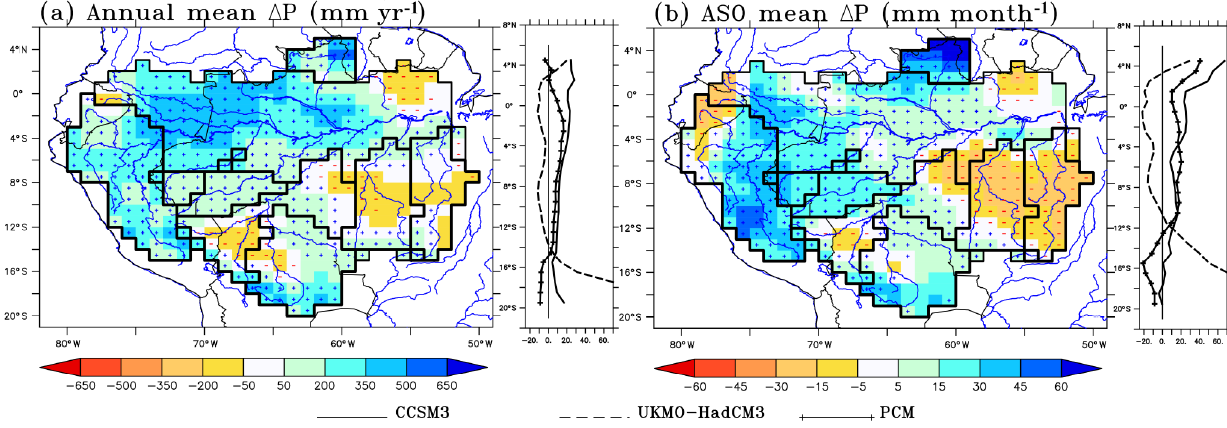
Figure 4. Maps indicate spatial change in (a) annual (mmyr − 1 ) and (b) ASO (mmmonth − 1 ) precipitation due to climate change (mean of the three GCM forcings) for the end of the century. The symbols indicate that more than two GCM forcings out of three give a precipitation increase ( + ) or decrease ( − ) on the grid cell. The black lines delineate the Amazon Basin and the catchments. Plots indicate the corresponding zonal mean of relative changes in precipitation (%) from the three GCM forcings.